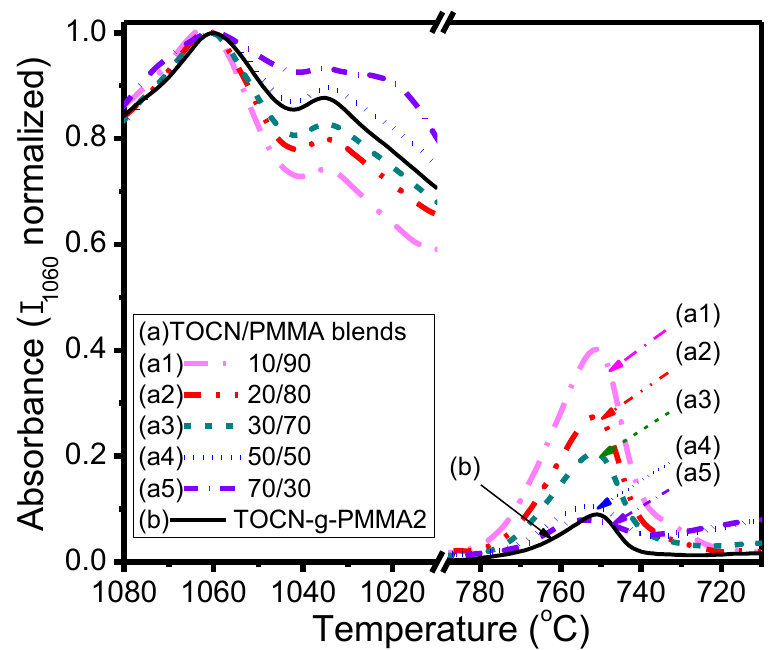
Figure 7. Fourier transform infrared (FT – IR) spectra (1080 – 730 cm − 1 ) of ( a1 – a5 ) TEMPO-oxidized cellulose nanofibers (TOCN)/PMMA blends and ( b ) TOCN – g – PMMA2 sample. Table 2. Conditions and characterization of surface-initiated initiators for continuous activator regeneration atom transfer radical polymerization (SI ICAR ATRP) of methyl methacrylate (MMA) from TOCN – Br.